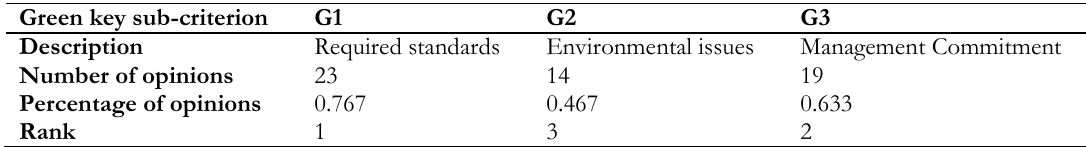
Table 13. Percentage of opinions and rank of each sub-criterion.